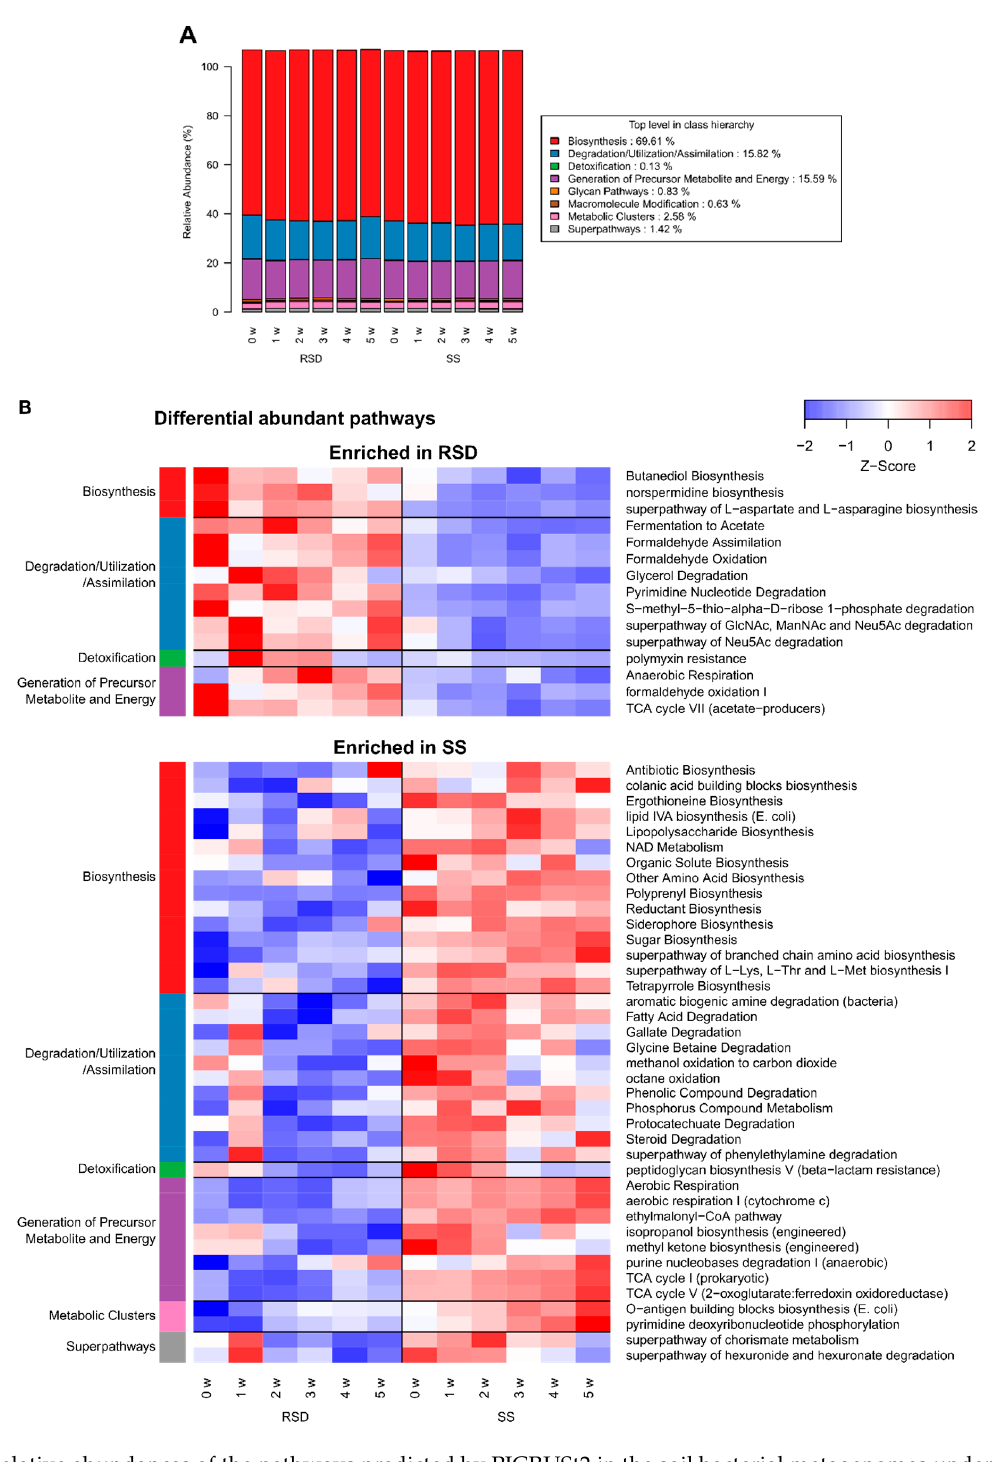
Figure 5. Relative abundances of the pathways predicted by PICRUSt2 in the soil bacterial metagenomes under reductive soil disinfestation (RSD) and soil solarization (SS). ( A ) Compositions of the predicted pathways (first level in MetaCyc hierarchy). The sum of relative abundance was more than 100% because some pathways were grouped into multiple parent classes. Most pathways in the “Superpathways” class overlapped with those in other classes; thus, such overlapped pathways in the “Superpathways” were filtered out. ( B ) Clustered heatmaps of the relative abundances of the predicted pathways (third level in MetaCyc hierarchy) were differentially abundant between RSD and SS (false discovery rate < 0.01). The heatmap color indicates the z-score normalized relative abundances. Blue denotes − 2, whereas red denotes 2. The left-side color indicates the parent class at the first level in the MetaCyc hierarchy. GlcNAc, N-acetylglucosamine; ManNAc, N-acetylmannosamine; Neu5Ac, N-acetylneuraminate; 0–5 w, treatment period for 0 to 5 weeks.